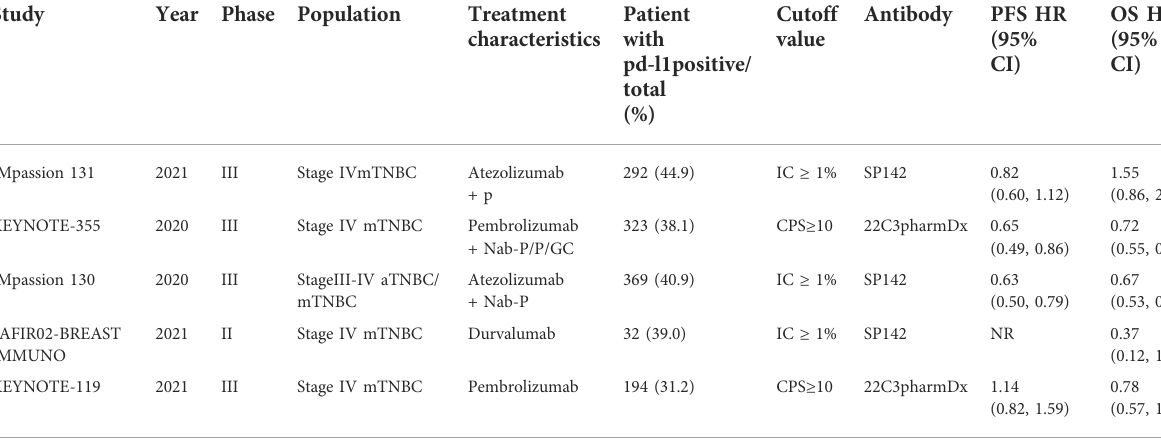
TABLE 1 Characteristics of the included studies in the